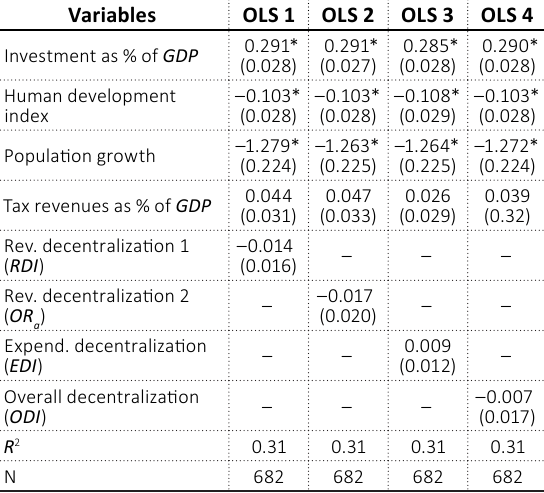
Table 2. Regressions of economic growth